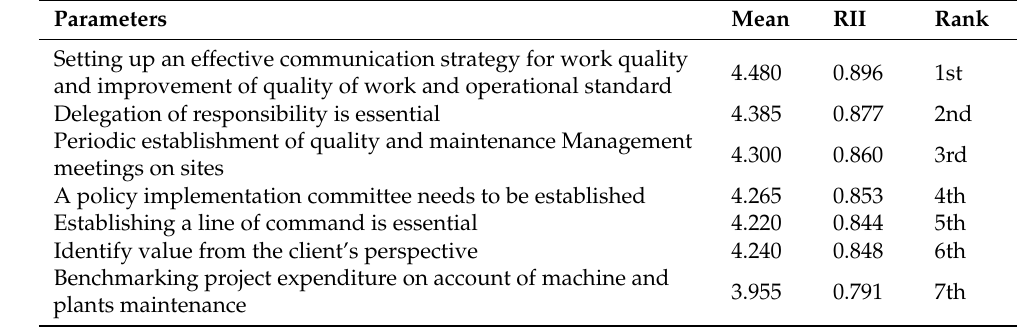
Table 10. Parameters on communication, authority, and